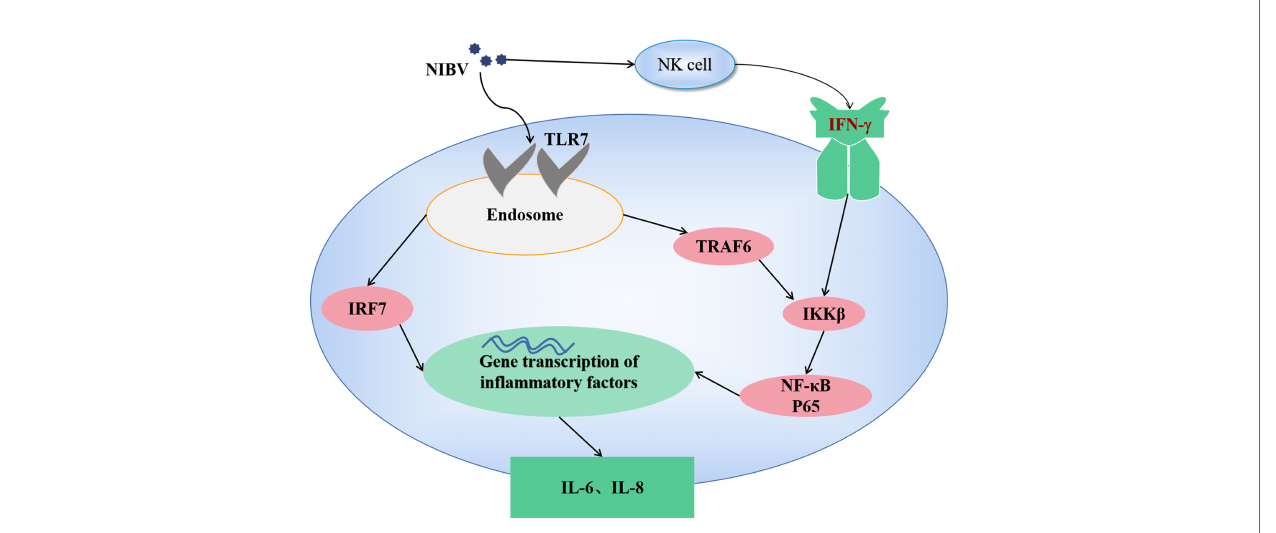
FIGURE 9 | The mechanism of TLR7/NF- k B signaling axis in NIBV